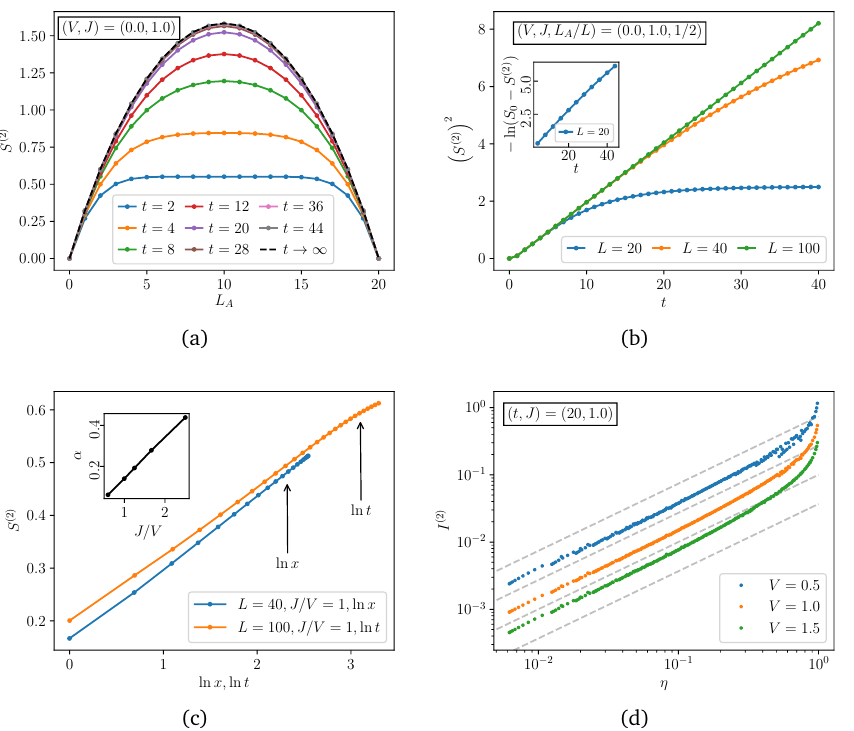
Figure 10: (a) Subsystem scaling of S ( 2 ) at V = 0. The t → ∞ curve is plotted from the analytical result Eqs. (32)–(33). (b) S ( 2 ) as a function of time at V = 0. An early (cid:112) t can be observed in large enough systems. The inset shows time scaling S ( 2 ) ∝ (cid:112) = L ( 3log2 − 2log ( that late time S ( 2 ) exponentially saturates to S 2 + 1 )) . (c) 0 4 Subsystem scaling of S ( 2 ) in the intermediate regime V / J ∼ 1. S ( 2 ) scales linearly / L ) /π ] ) with very close slopes α . The with both log t and log x ( x ≡ log [ L sin ( π L A inset shows α scales linearly with J / V . (d) Mutual information I ( 2 ) as a function of subsystem cross-ratio η at various V / J